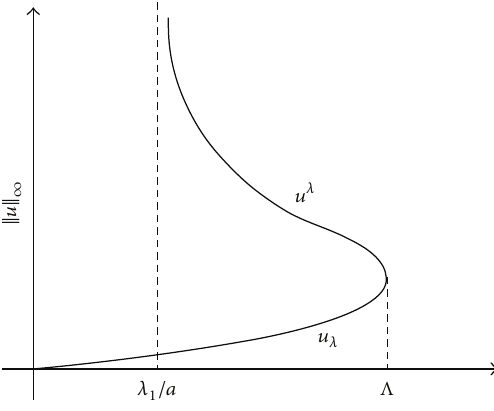
Figure 3: Precise bifurcation diagram on a unit